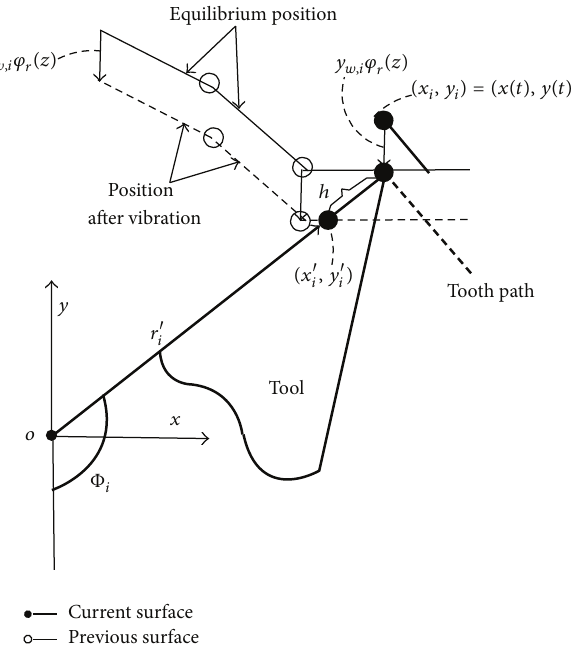
Figure 17: The geometrical relationship between tool and workpiece when tooth entering